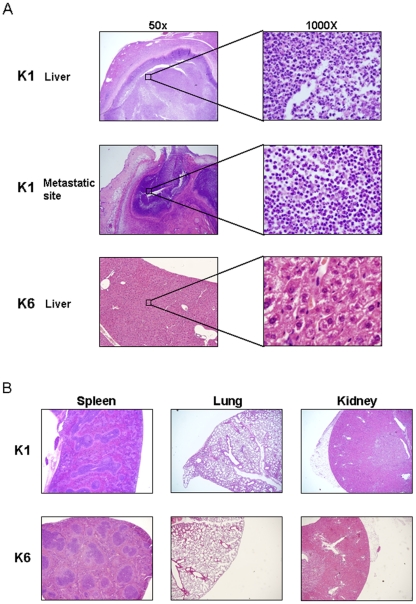
Pathologic features of abscesses due to serotypes K1 and K6 K. pneumoniae in different mouse tissues.(A). Necrosis can be seen in the liver and at metastatic infection sites in mice injected with K1 K. pneumoniae. No inflammation was seen in the liver of mice injected with serotype K6. (B). Inflammation was not found in the lungs, spleen, or kidneys of mice injected with serotypes K1 and K6.